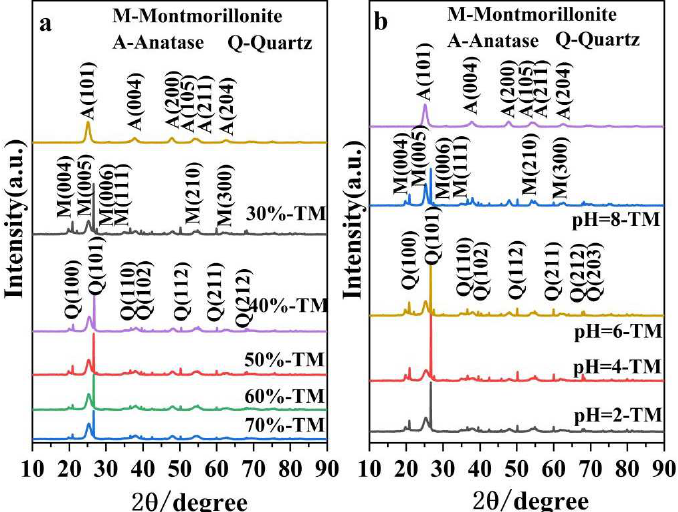
Figure 1. X-ray diffraction patterns of TiO 2 -montmorillonite (MMT) composites prepared using ( a ) different TiO 2 /MMT mass ratios at a reaction temperature of 160 °C, a dwelling time of 24 h, and a pH of 6, and ( b ) different pH values at a reaction temperature of 160 °C, a dwelling time of 24 h, and a TiO 2 mass ratio of 30 wt%.